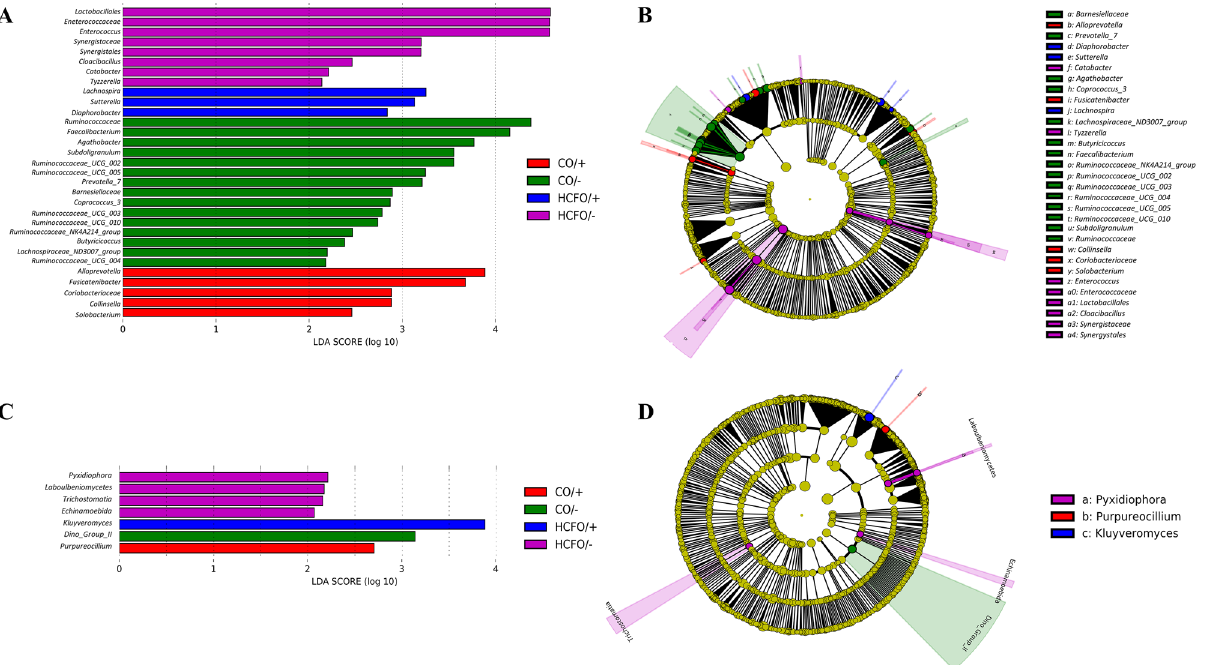
Figure 4. Effect of size measurements (LEfSe) at phylum and genus levels. Linear discriminant analysis (LDA) combined with LEfSe showing a list of possible biomarkers that enable discrimination between groups. LDA ≥ 2.0 and p < 0.05 were considered significant in Kruskal–Wallis and pairwise Wilcoxon tests. ( A ) Distinct bacterial phyla and genera biomarkers by group. ( B ) Cladogram reporting the bacterial taxa (highlighted by small circles and shading) showing different abundance values in the groups. Circles’ diameters are proportional to the taxon’s abundance, and the shadow size is proportional to the effect size. ( C ) Distinct eukaryotic phyla and genera biomarkers by group. ( D ) Cladogram reporting eukaryotic taxa showing different abundance values in the groups. Figure created on Galaxy platform 73,74